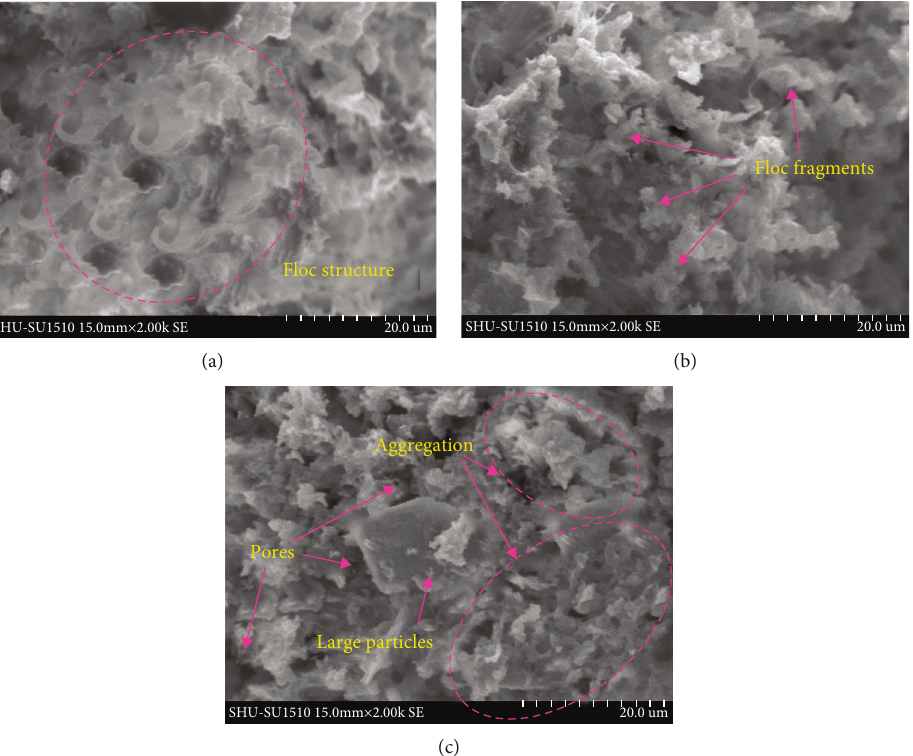
Figure 9: SEM photos of the samples at 2000x: (a) original sludge; (b) sludge treated by microwave (only); (c) sludge treated by acid-